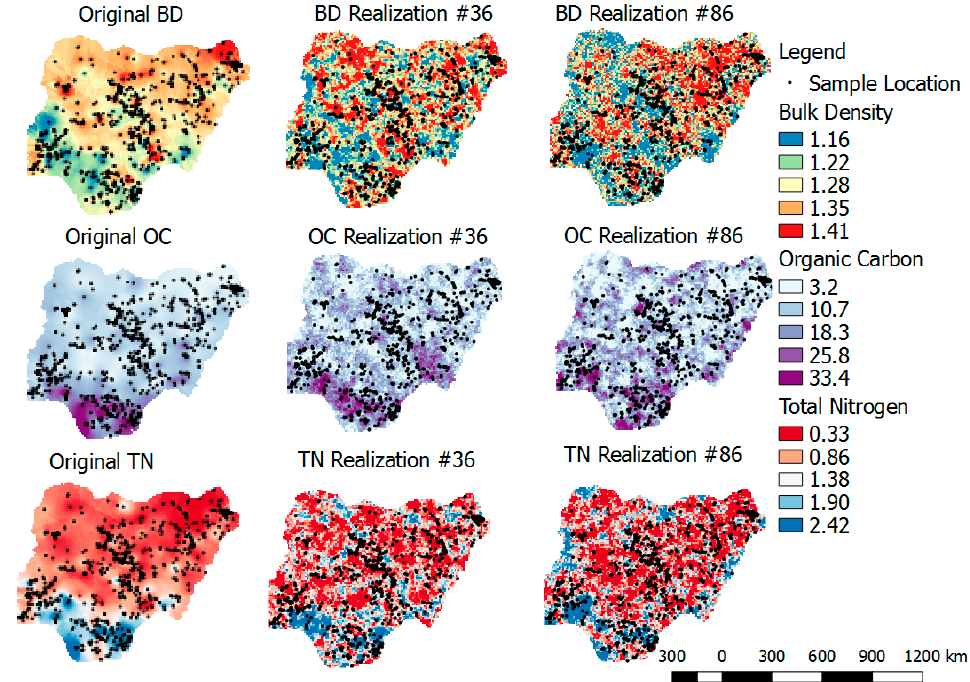
Figure 15. Original soil health indicators and simulations of the back-transformed simulated randomly selected realizations #36 (second column) and #86 (third column), using MAF (BD = bulk density (g/cm 3 ); OC = organic carbon (g/kg); and TN = total nitrogen (g/kg)).